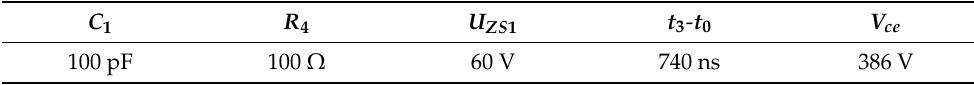
Table 4. Influence of U ZS 1 on the turn off